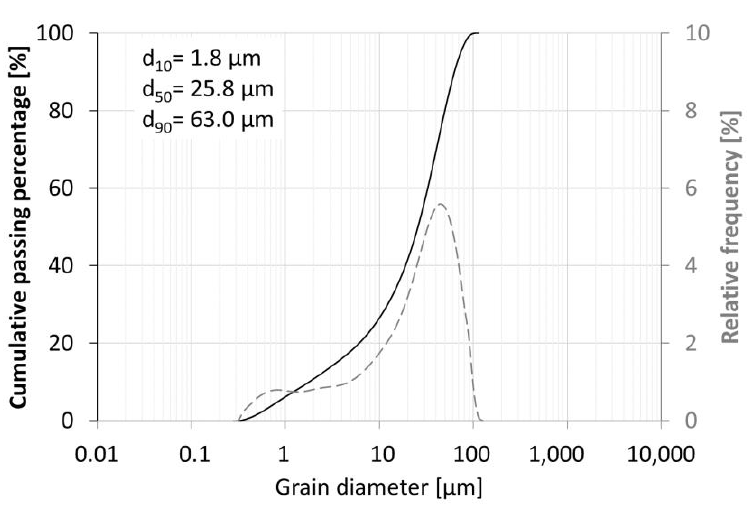
Figure 3. SSA grain size distribution.